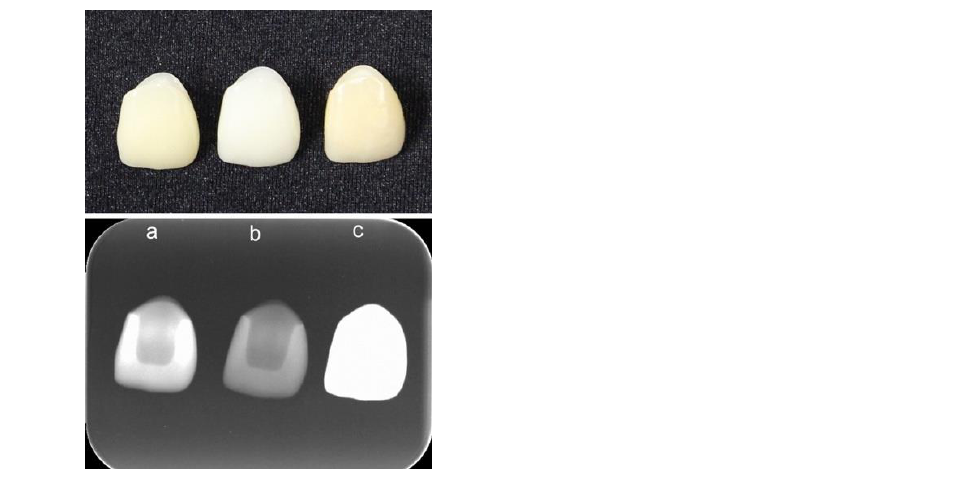
Figure 10. Photograph (upper) and X-ray image (lower) of anterior crowns. ( a ) CAD/CAM hybrid resin (GC, Cerasmart ® ); ( b ) pressed lithium disilicate (GC, LiSi ® Press); and ( c ) 5Y zirconia (Shofu Lucent ® FA).